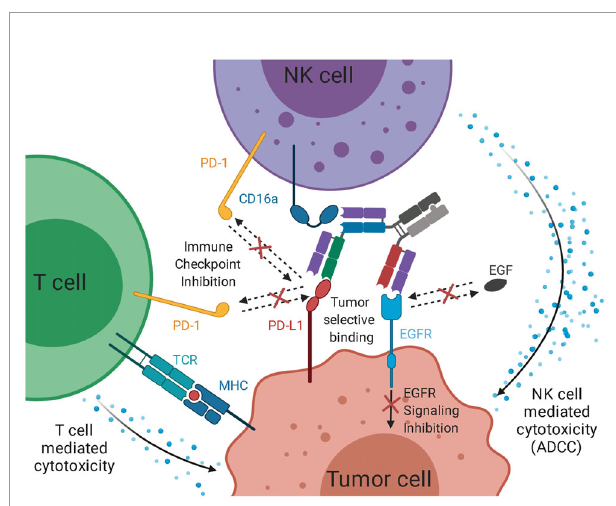
FIGURE 7 | Schematic representation of the intended mode of action of the trispeci fi c checkpoint inhibitor and natural killer cell engager. As EGF-binding is blocked, downstream signaling is inhibited. Simultaneously, PD-L1 is blocked, inhibiting interaction with PD-1 on T cells and NK cells. PD-L1 inhibition facilitates T cell-mediated cytotoxicity against the tumor. While the simultaneous binding of EGFR and PD-L1 mediates an elevated tumor speci fi city, the recruitment of cytotoxic NK cells via CD16a engagement, paired with checkpoint inhibition, leads to an effective ADCC